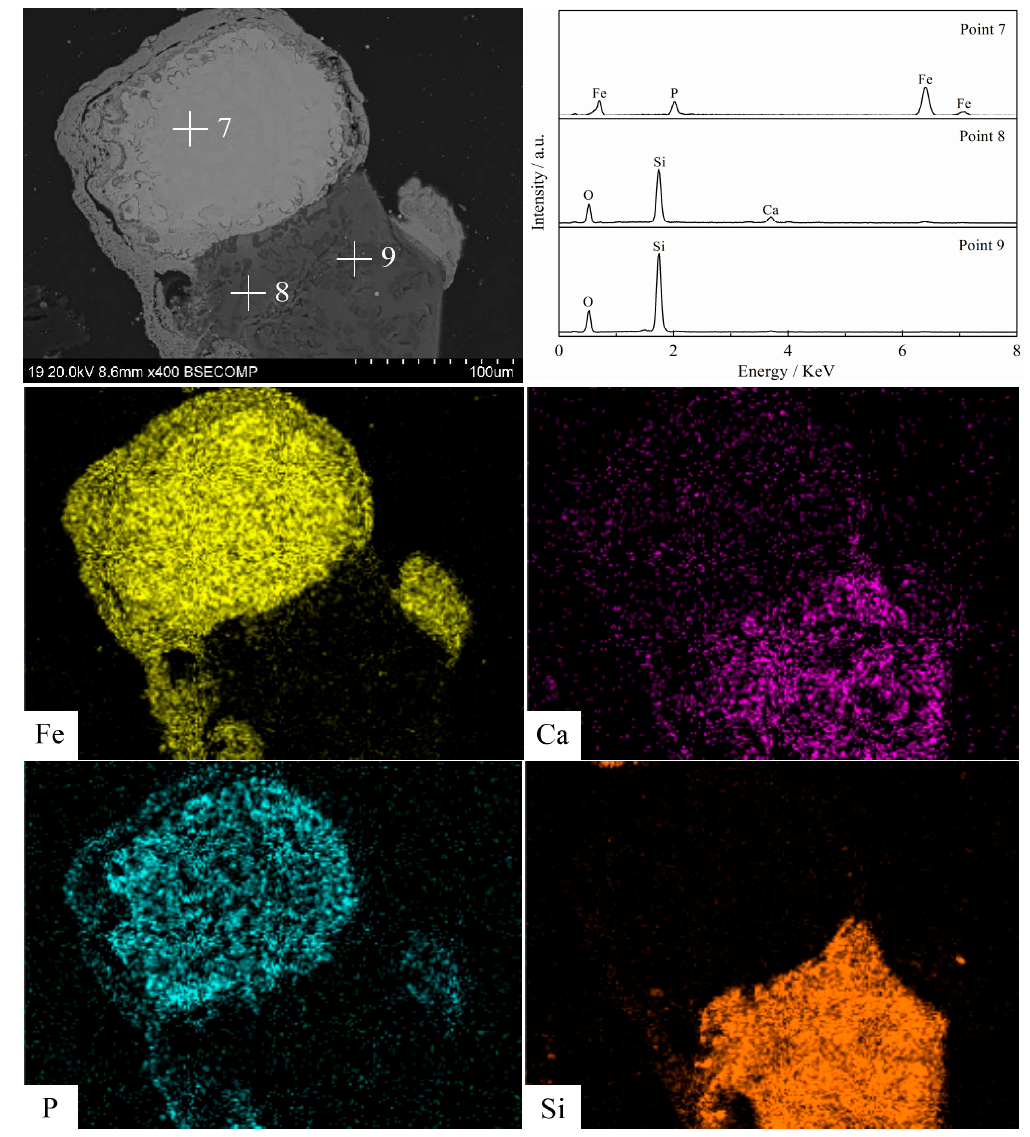
Figure 16. SEM image and EDS spectra and line-by-line scanning analysis of the reduction product in the Ca 10 (PO 4 ) 6 F 2 –SiO 2 –Fe 2 O 3 –C system (reduction temperature of 1573 K and reduction time of 60